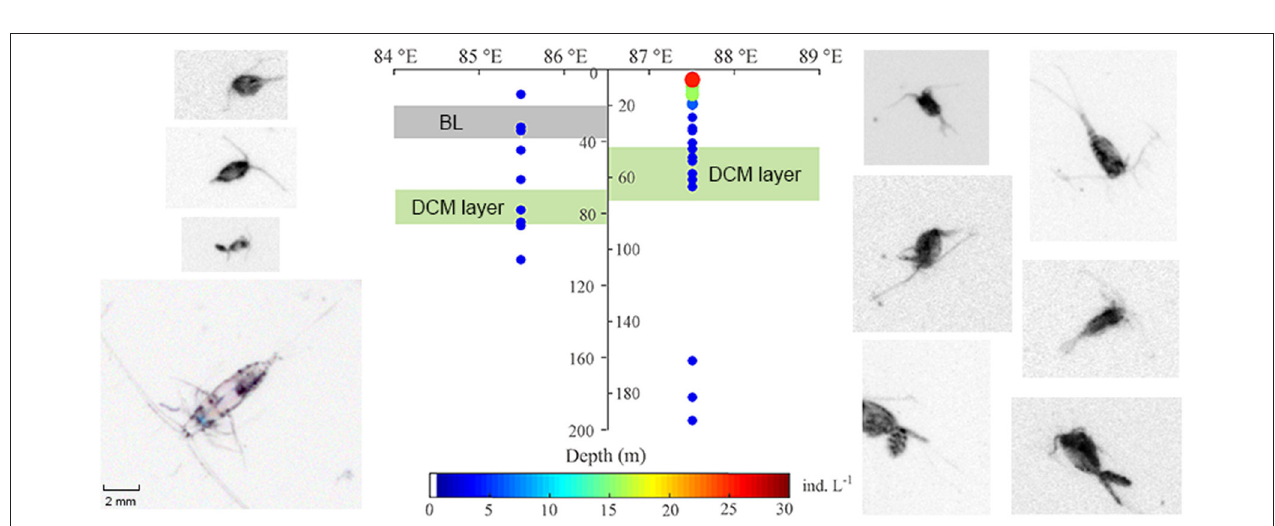
FIGURE 5 | Comparison of vertical distribution and abundance of copepods from the video plankton recorder (VPR) in the upper 200m at the BL-affected and -unaffected stations. The shaded gray indicates the depth and thickness of the BL, while the shaded lime indicates the depth and thickness of the deep Chl a maximum (DCM) layers. Copepod photos were taken from the sampling stations and their colors have been inverted to capture more details.